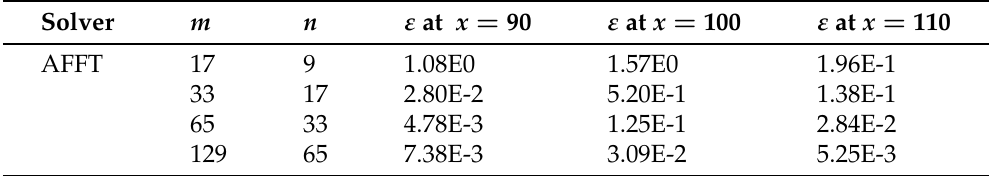
Table 3. Numerical results of the AFFT solver in Example